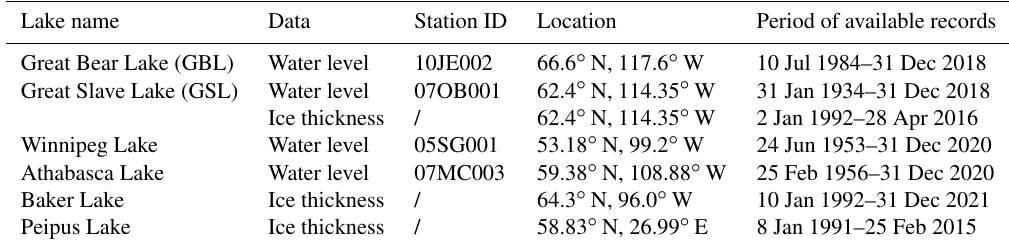
Table 2. In situ lake water level gauging stations and LIT observation sites used in this